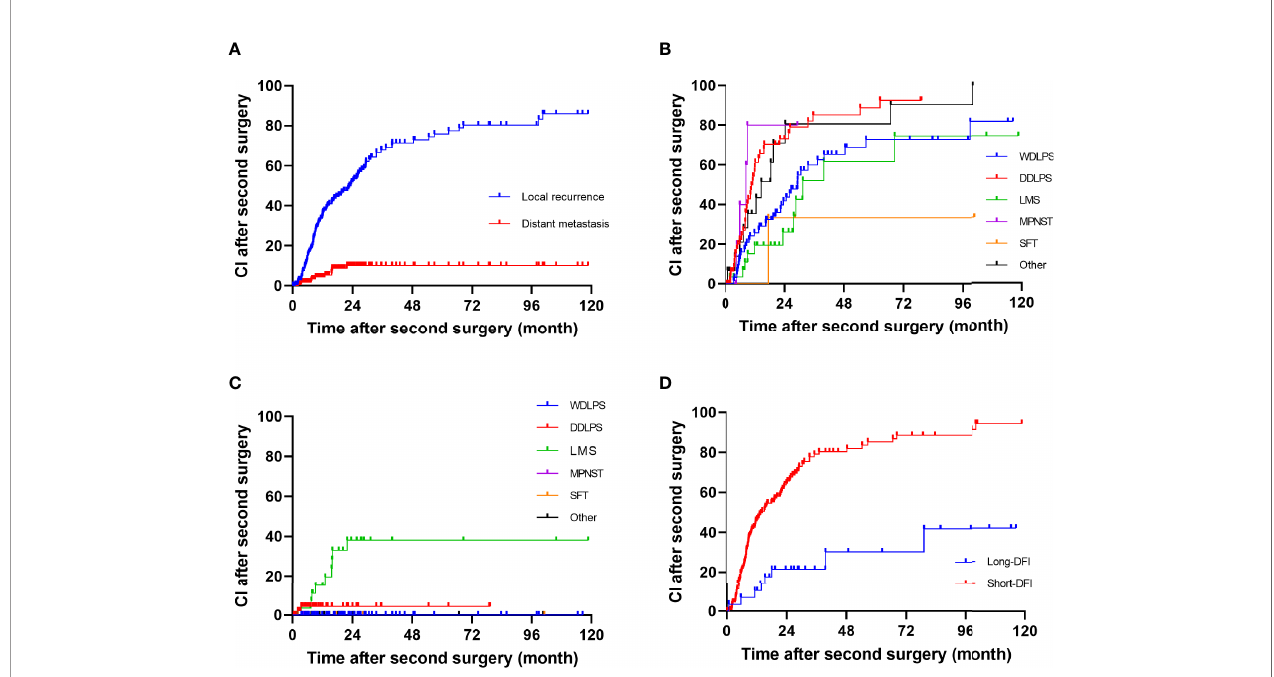
FIGURE 1 | Cumulative incidence in patients after a second surgery for all patients: (A) all, (B) local recurrence, (C) distant metastasis, and (D) long disease-free interval group and short disease-free interval group.